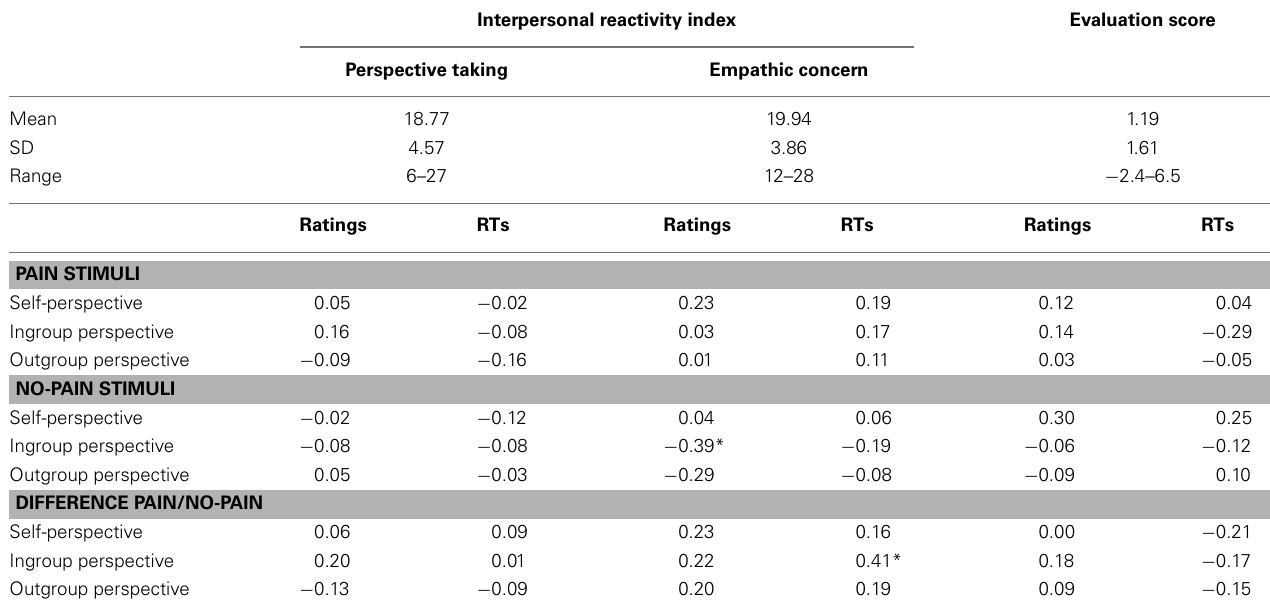
Table 1 | Cognitive (the PerspectiveTaking subscale) and affective (the Empathic Concern subscale) subscales of the Interpersonal Reactivity Index (IRI; Davis, 1983; French version: Guttman and Laporte, 2002), evaluation scores, and correlation